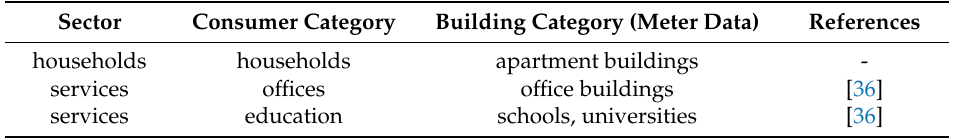
Table 2. Model overview, hourly district heat consumption.